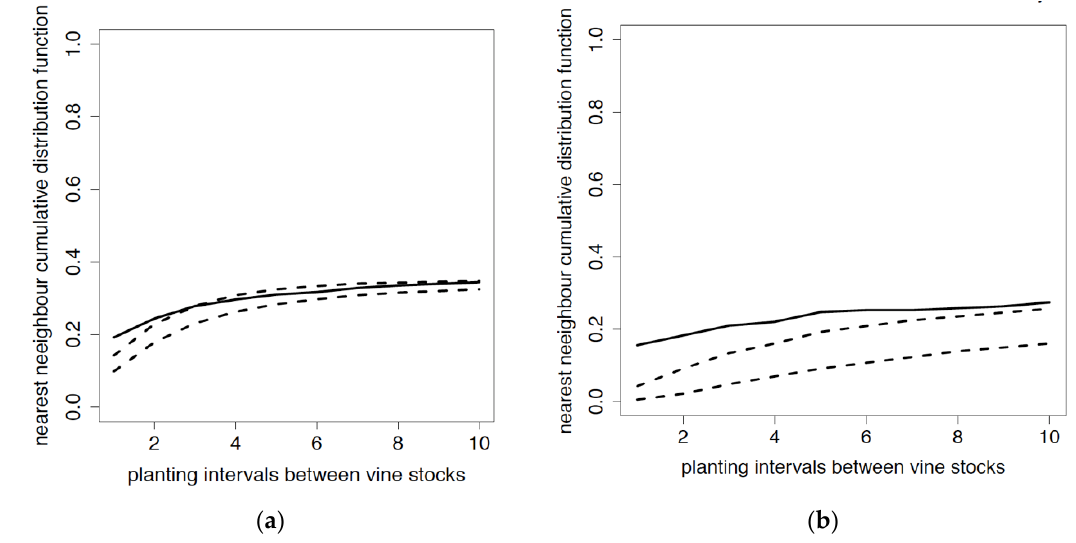
Figure 7. Cumulative distribution function of the distance of a vine infected in 2009 – 2014 to its nearest neighbour infected in 2003 – 2008. ( a ) GLRaV-1, ( b ) GVA. Spotted lines delineate the confidence bands at 95% of the cumulative distribution under independence assumption. A spatial dependence between data is proven when probability to find the nearest neighbour at a distance less than X (solid line) is outside the confidence band. x -axis: planting intervals between vine stocks; y -axis: probability to find the nearest neighbour at a distance less than X .